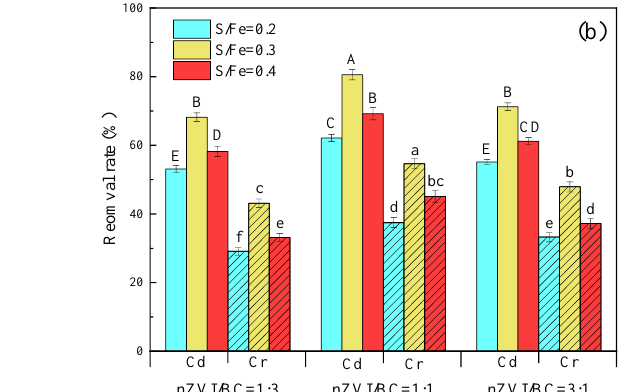
Figure 2. The SEM images of ( a , b ) BC and ( d , e ) BC-SnZVI; the EDS survey for ( c ) BC and ( f ) BC-SnZVI. The XRD patterns of BC and BC-SnZVI are shown in Figure 3. The spectra of BC showed identical spectra with broad diffraction peaks at 2θ = 24°, which were attributed